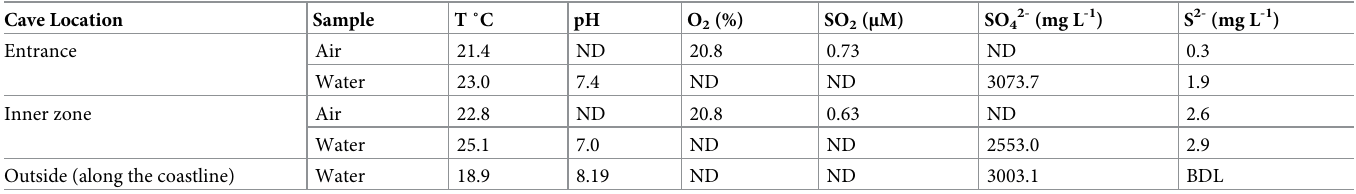
Table 1. Physico-chemical parameters of waters and air sampled at the entrance and in the inner zone of Fetida Cave and along the coastline a,b . Cave